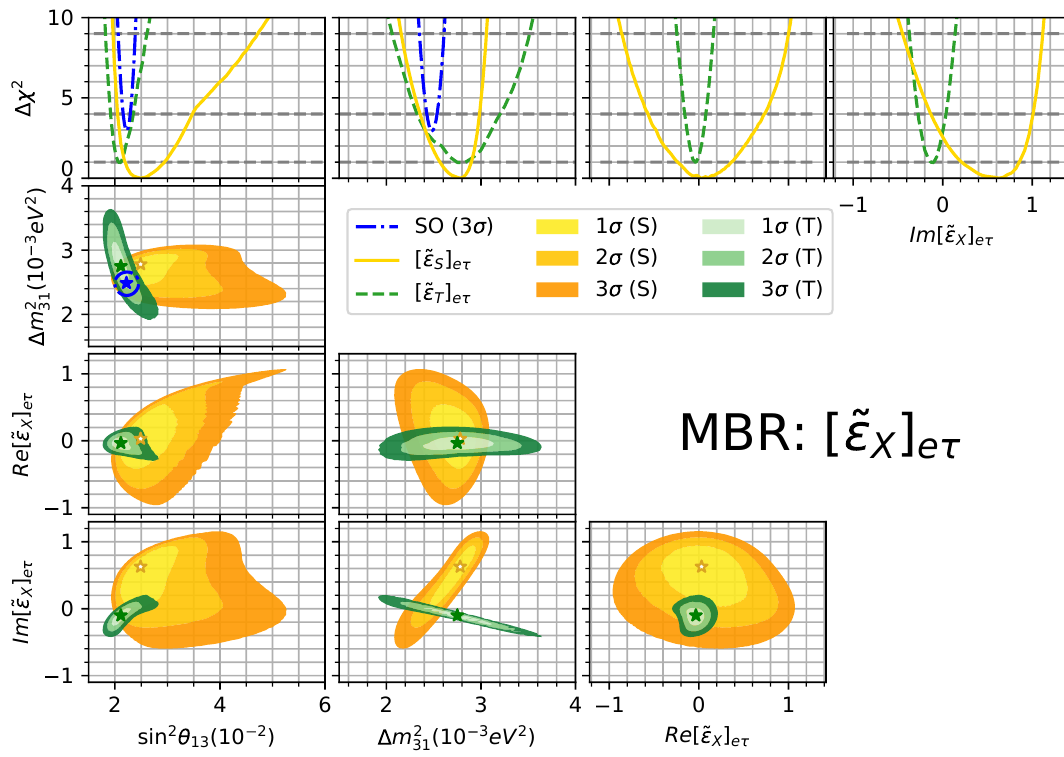
of medium baseline reactors Figure 3 . Upper panel: the 1D projection of the ∆ χ 2 ≡ χ 2 − χ 2 min (MBR) in the presence of [˜ (cid:15) ] for each parameter marginalized over all the parameters shown X eτ here. Lower panels the contour levels for oscillations parameters and the BSM couplings at 1 σ , 2 σ , and 3 σ . In green (yellow) is the NSI tensor (scalar) case and in dash-dotted black is the standard neutrino oscillation